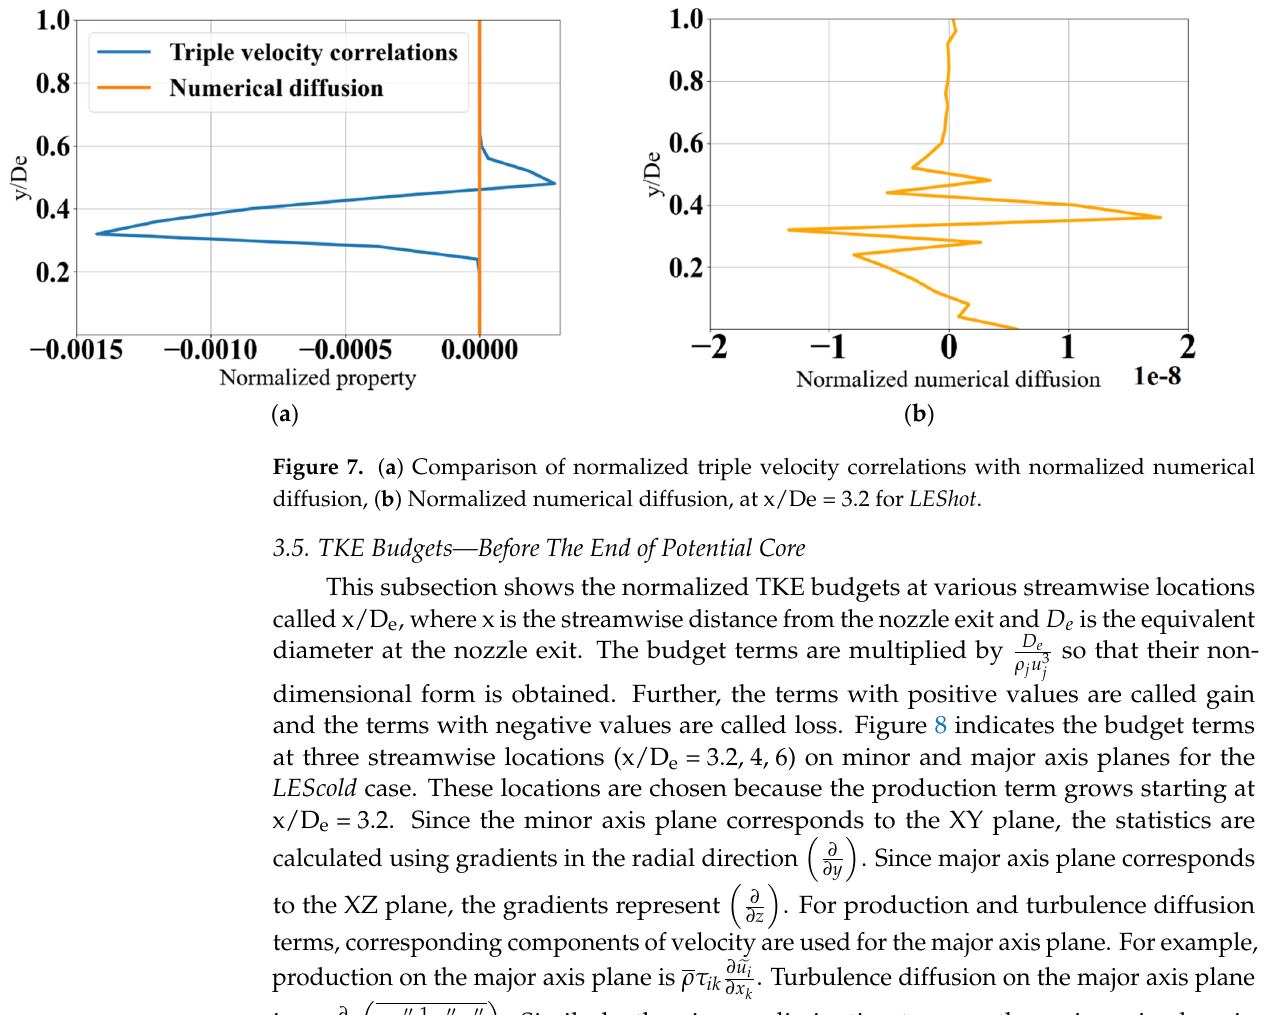
Figure 6. Temporal evolution of higher-order statistics (normalized by ρ j u 3 ) for LEShot on minor axis plane at x/D e = 3.2. ( a ) Normalized triple-velocity correlations, ( b ) Normalized pressure-velocity correlations.